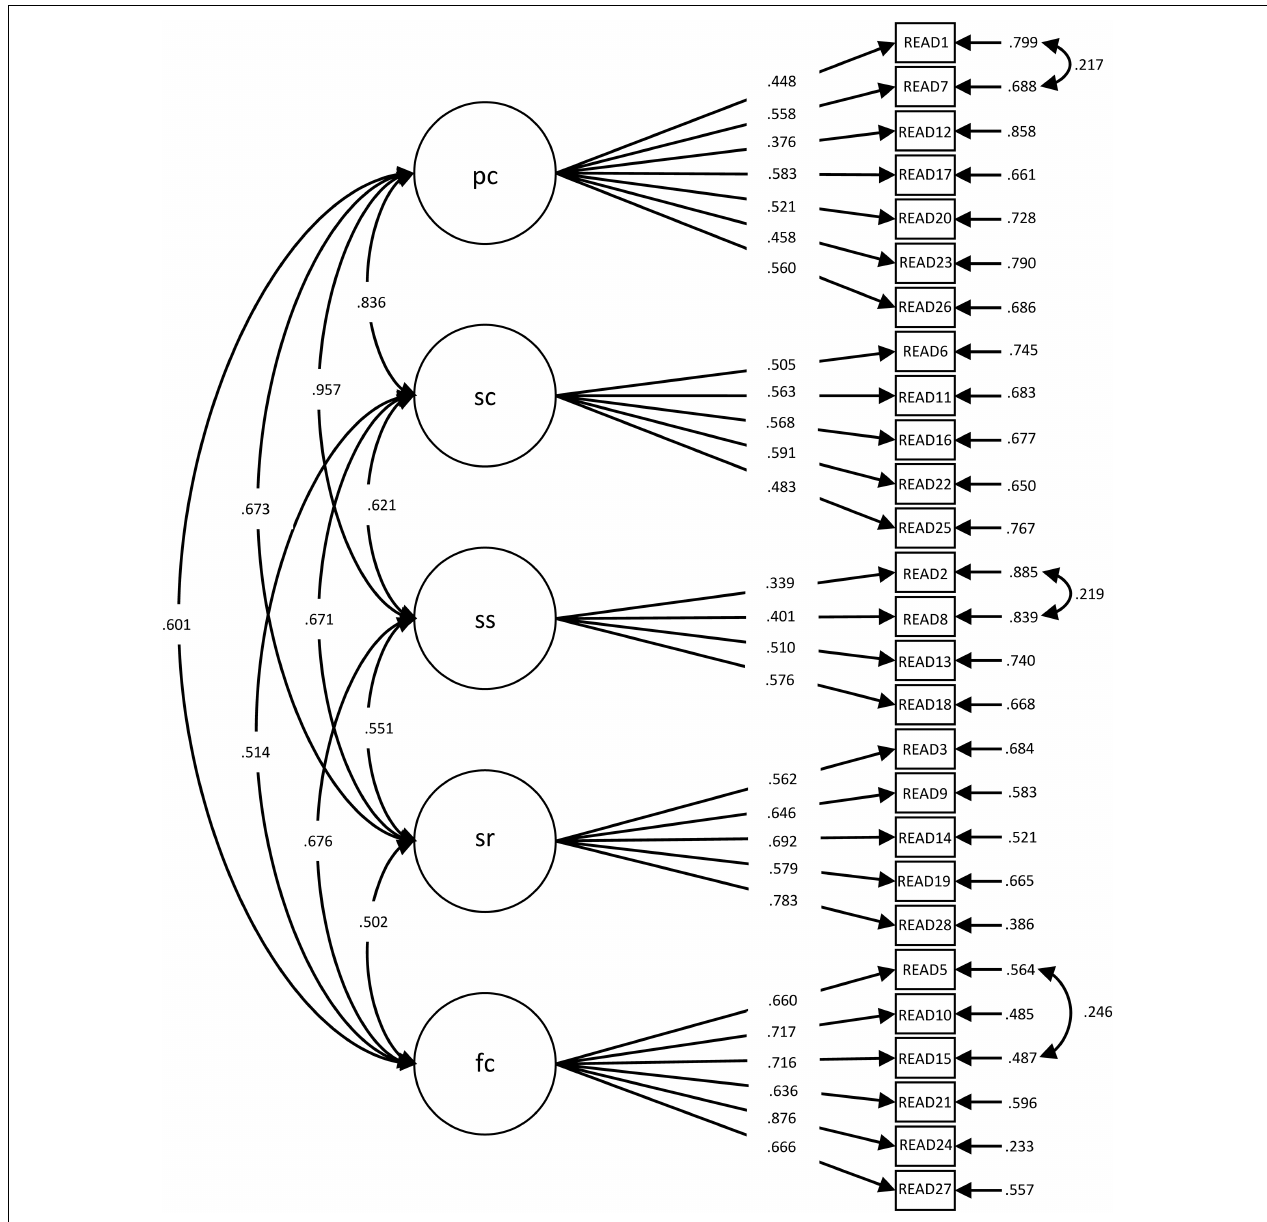
FIGURE 2 | Factor loadings for the five-factor, 27-item model (Switzerland: N = 349). pc, personal competence; sc, social competence; ss, structured style; sr, social resources; fc, family